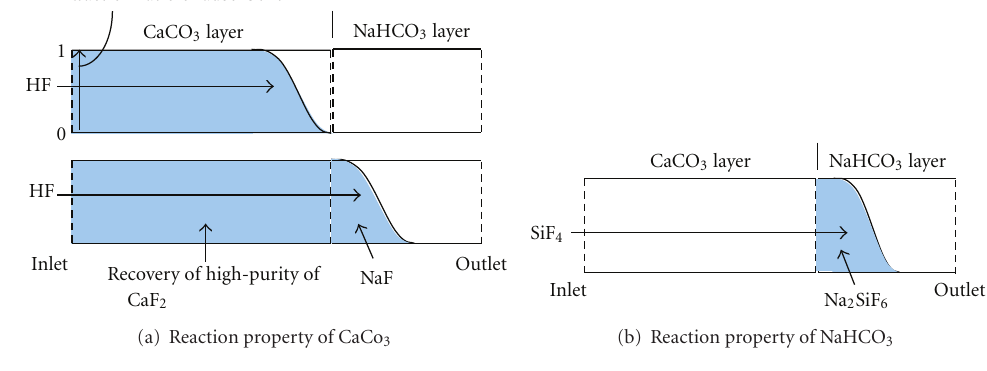
Figure 2: Schematic of the dry-type gas treatment system.